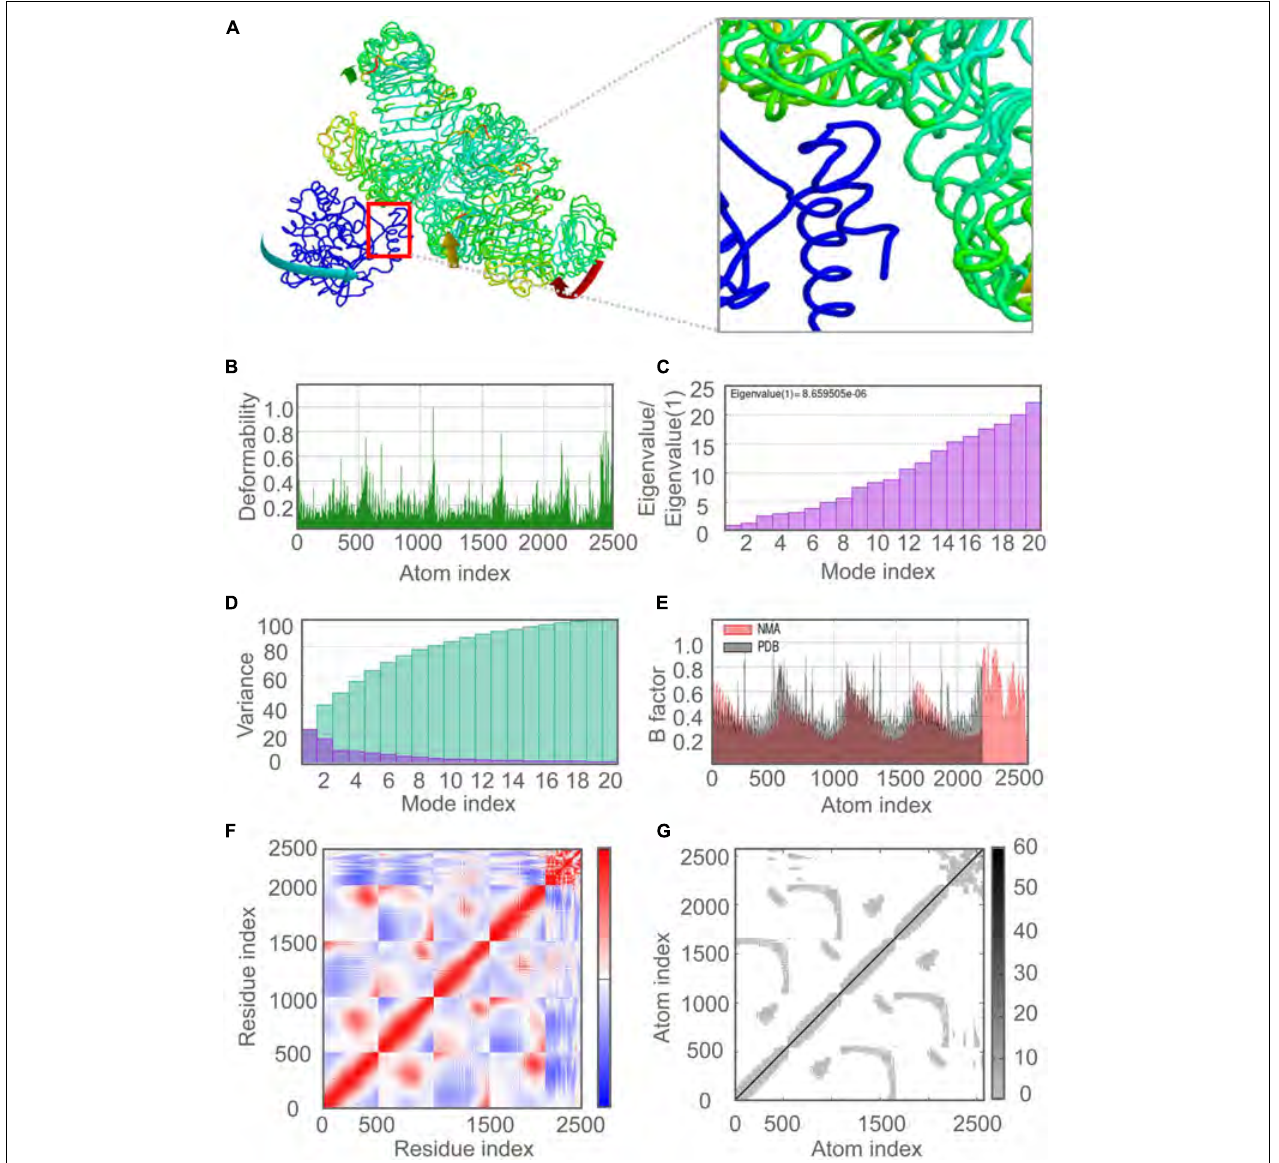
FIGURE 7 | Molecular dynamics simulation of the C543P candidate and TLR2. (A) NMA mobility. The direction of the arrow indicates the direction of molecular motion. Blue represents the C543P molecule and green expresses the TLR2 receptor. (B) variability; (C) eigenvalues; (D) variance (Purple for individual variance, green for cumulative variance); (E) B-factor; (F) covariance plot (red for correlated motion, white for uncorrelated motion, the blue color indicates anti-correlated motion); (G) elastic network (dark gray areas indicate harder areas).